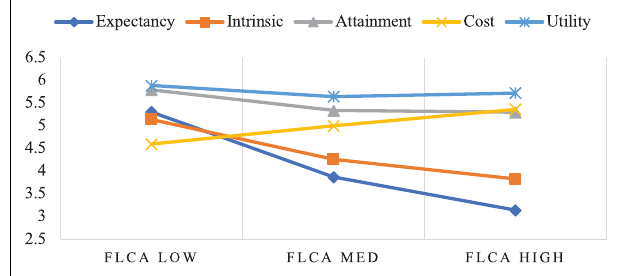
FIGURE 2 | Relationship between FLCA and expectancy-value motivation.